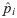
Standard deviation comparison for Dengue importation probability.(a) Figure shows the point estimates for the import probability p^i. (b) Figure visually plots the bootstrap standard deviation estimates for pi across Texas counties. (c) Figure visually plots the analytic standard deviation estimates for pi across Texas counties. (d) Figure plots the standard deviations of bootstrap vs. analytic and shows a strong equivalence between the two. Each red dot represent the estimations for one county.